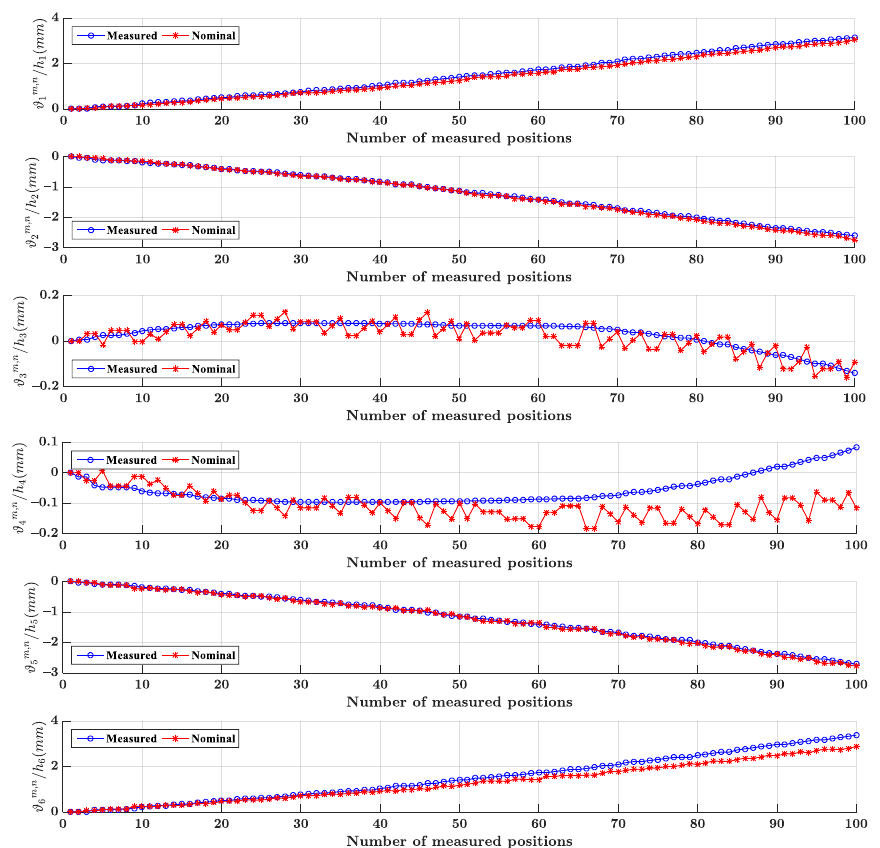
Figure 5. Measured joint positions 𝒒 𝑛 for calibration.